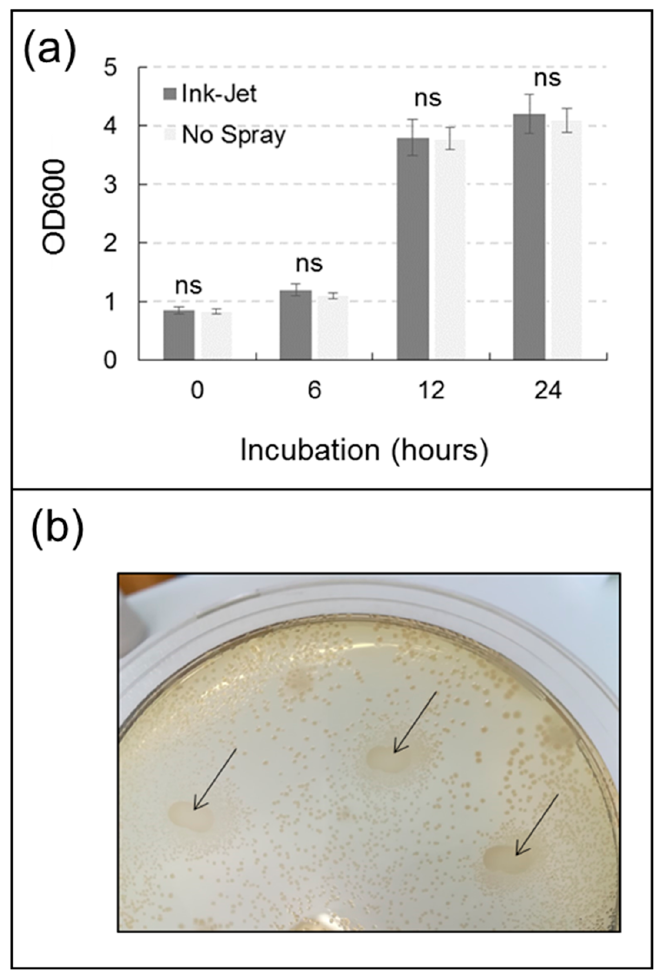
Figure 7. Growth of Pseudomonas fluorescens in relation to treatment with ink-jet spray system ( a ). Data are means ± standard deviation, ns = statistically insignificant difference (Duncan’s test). Image of a detail of a Petri dish containing LB substrate with the addition of agar and on which a suspen- sion of Pseudomonas fluorescens cells has been sprayed with the ink-jet system at three points (black arrows) ( b ).